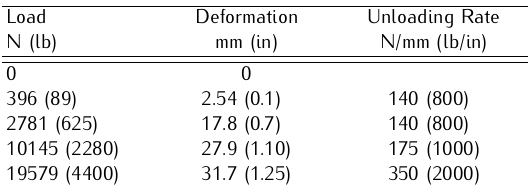
Table 1. Typical cushion properties for crew seat utilized in this study